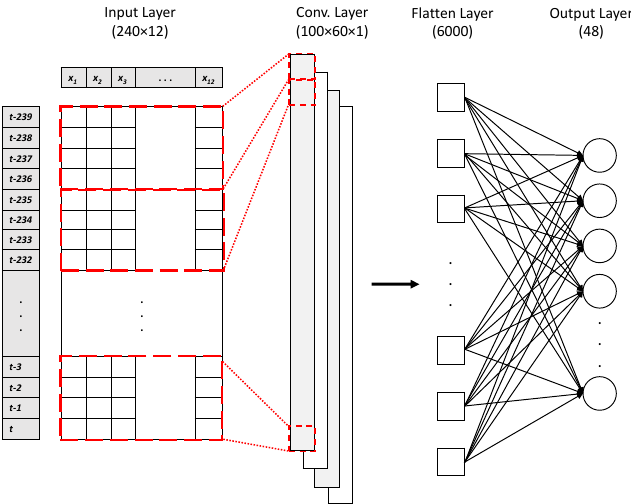
Figure 3. CNN model architecture with filter and stride size of